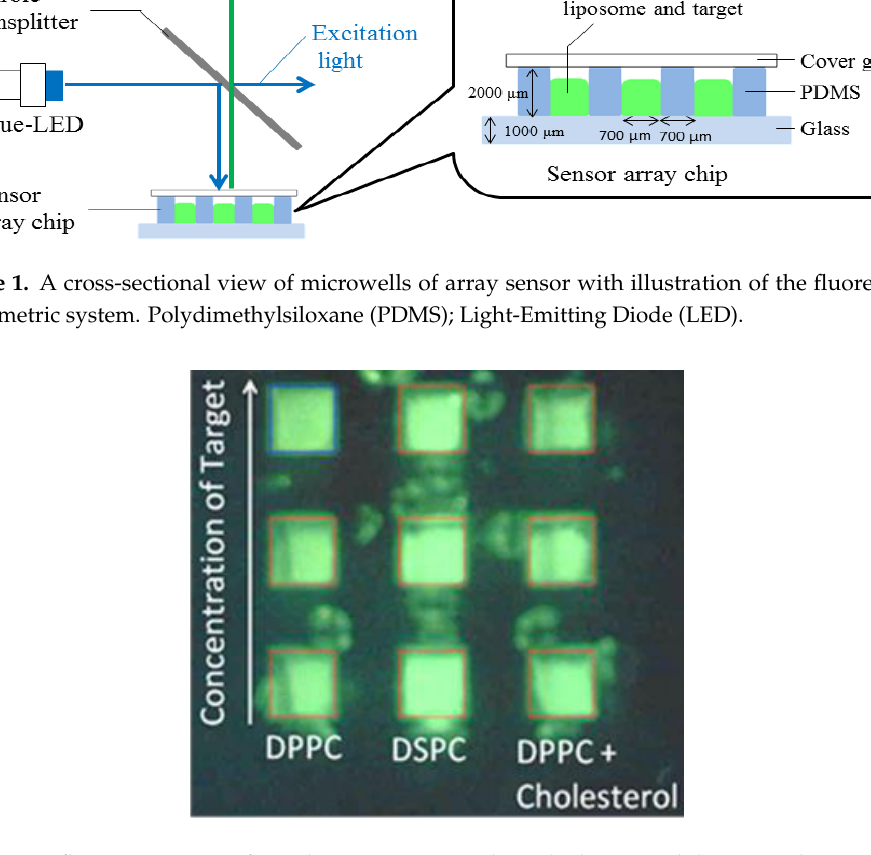
Figure 2. A fluorescent image from the array sensor. Along the horizontal direction, the microwells were filled with different phospholipid liposome species, and along the vertical direction, they were provided with different concentrations of the same kind of target protein. 1,2-dipalmitoyl-sn-glycero- 3-phosphocholine (DPPC); 1,2-distearoyl- sn -glycero-3-phosphocholine (DSPC).